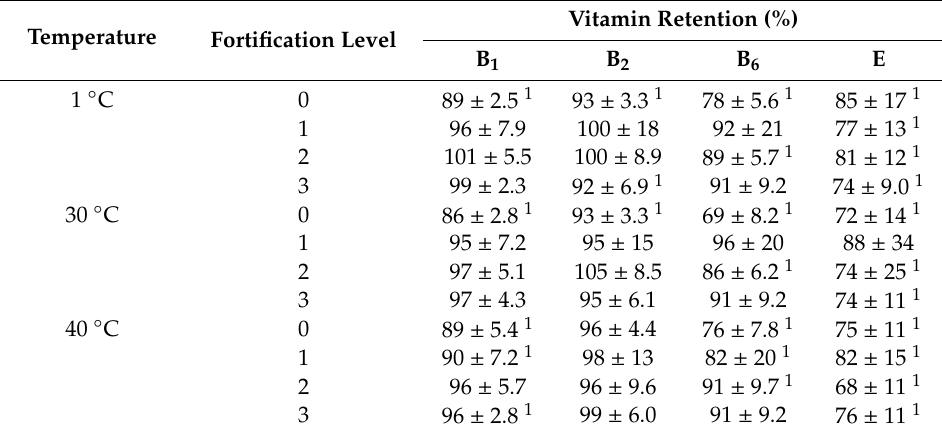
Figure 3. Trend plots forced through the initial values: vitamin fortification Level 3. Table 2. Vitamin retention after 24 months of storage.